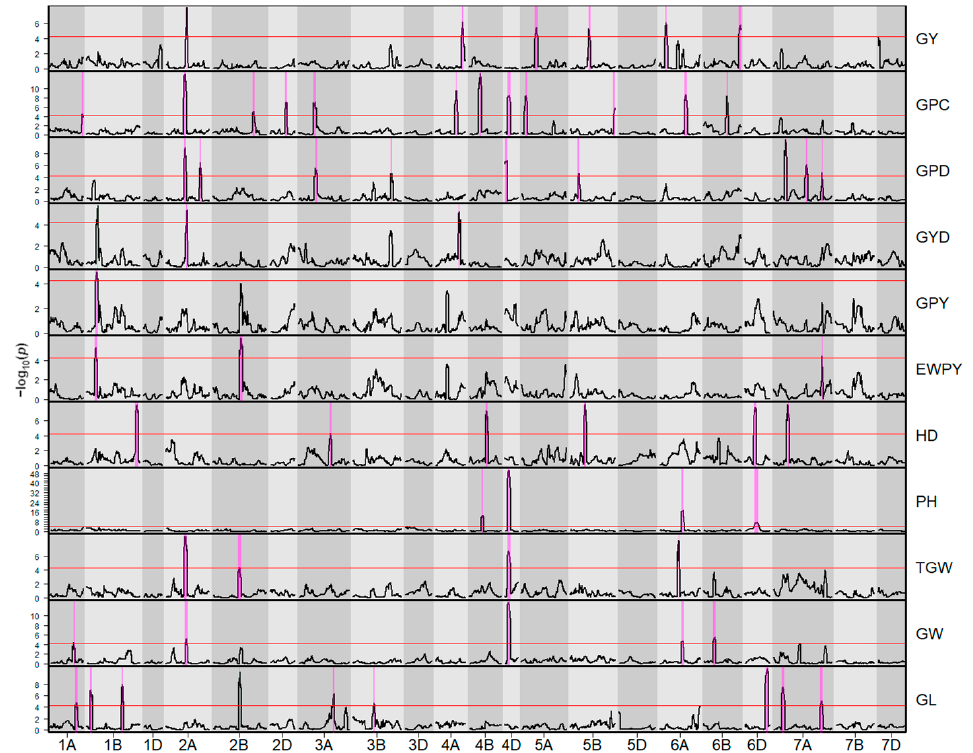
Figure 1. p -value curves for quantitative trait loci detected across environments: grain yield (GY), grain protein content (GPC), grain protein deviation (GPD), grain yield deviation (GYD), grain protein yield (GPY), equal-weight protein yield (EWPY), heading date (HD), plant height (PH), thousand-grain weight (TGW), grain width (GW), and grain length (GL). The significance threshold is represented by the red line. Support intervals are drawn as magenta stripes.